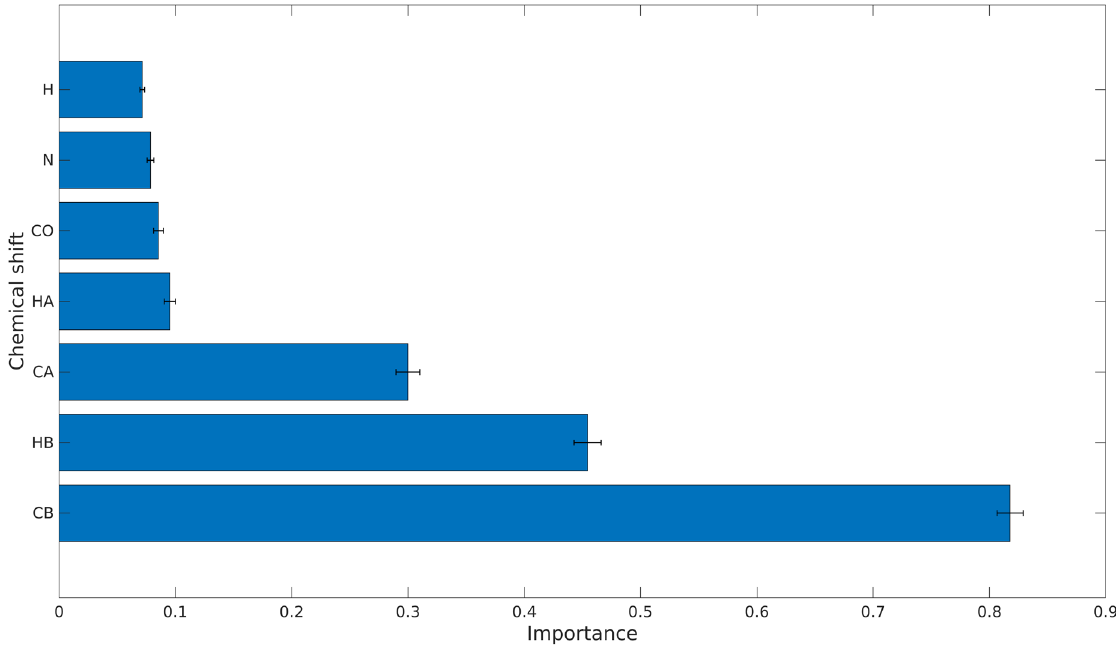
Fig 4. Importance of different chemical shifts for the classification models, measured as the error rate of LDA models when making classifications on a test set with a shuffled column corresponding to a single chemical shift. The results shown are the mean values from performing 1,000 tests on each chemical shift, with error bars representing one standard